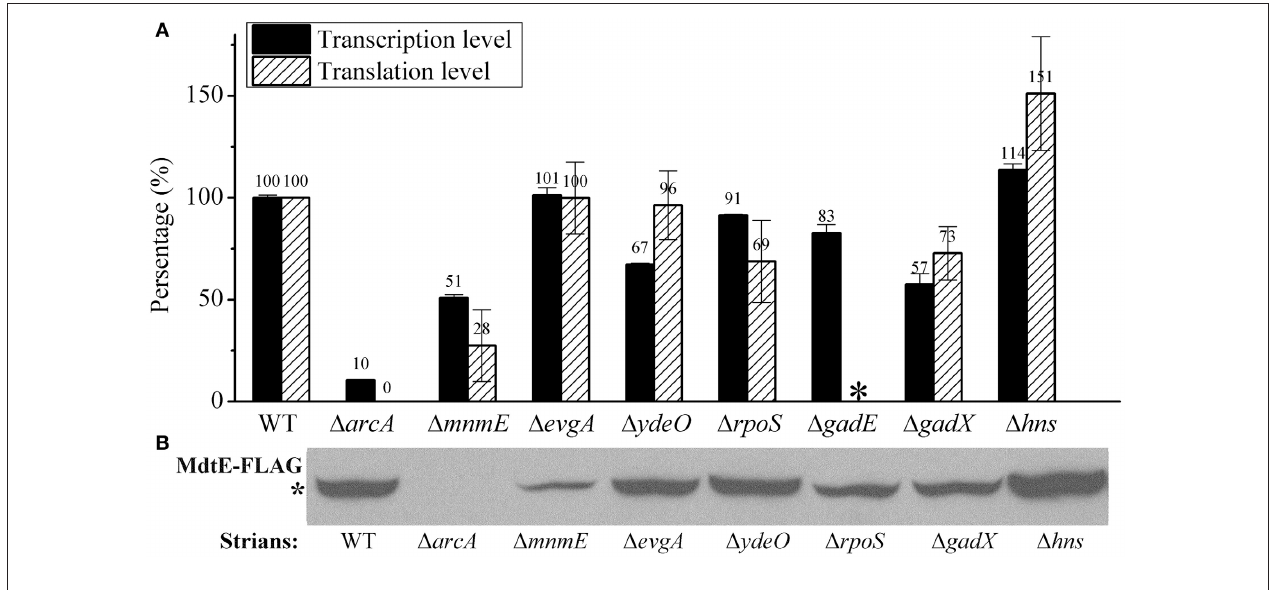
FIGURE 2 | MdtEF expression in various mutants at both transcription and translation level under anaerobic condition. (A) Transcription of gadE-mdtEF was determined by β -galactosidase activity of P gadE-lacZ , and translation of the gene is determined by Western blot to detect the production of MdtE-FLAG. (B) Production of chromosomal MdtE-FLAG in various mutants. Cells were grown anaerobically to exponential phase